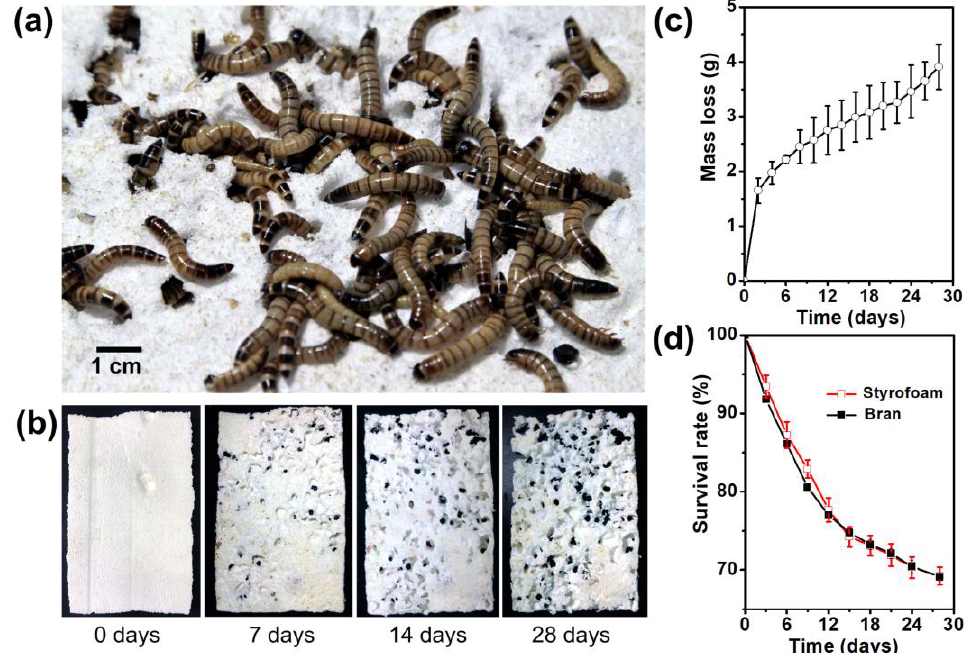
Figure 2. PS foam-eating activities of Zophobas atratus . ( a ) Zophobas atratus like to eat and penetrate PS foam. ( b ) Increasing hollows in the Styrofoam block; ( c ) consumption of PS foam by a group of Zophobas atratus ; ( d ) survival rate of PS foam-eating and normal diet (bran)-eating Zophobas atratus, reprinted with permission from [32].